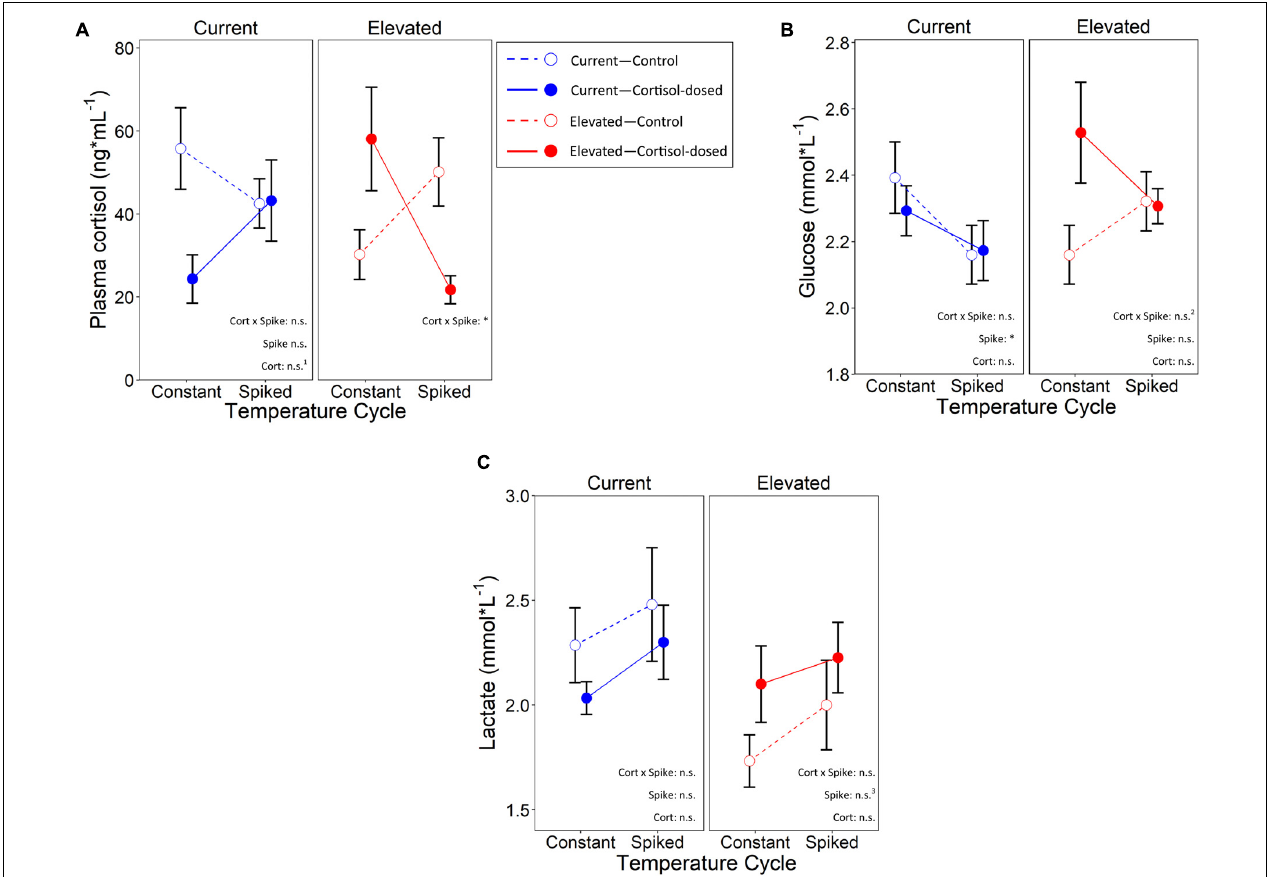
FIGURE 5 | Effects of cortisol treatment and temperature cycle on (A) —plasma cortisol, (B) —whole blood glucose, and (C) —whole blood lactate in juvenile Chinook salmon. Open circles depict control and closed circles depict cortisol-dosed. For the temperature cycle groups, constant indicates fish remained at a constant temperature, and spiked are fish who were exposed to 3 days of thermal spikes. n.s. and *represent a p -value of > 0.05 and < 0.05, respectively. n.s. 1 , n.s. 2 , and n.s. 3 represents a marginal significance of p = 0.089, p = 0.056, and p = 0.090